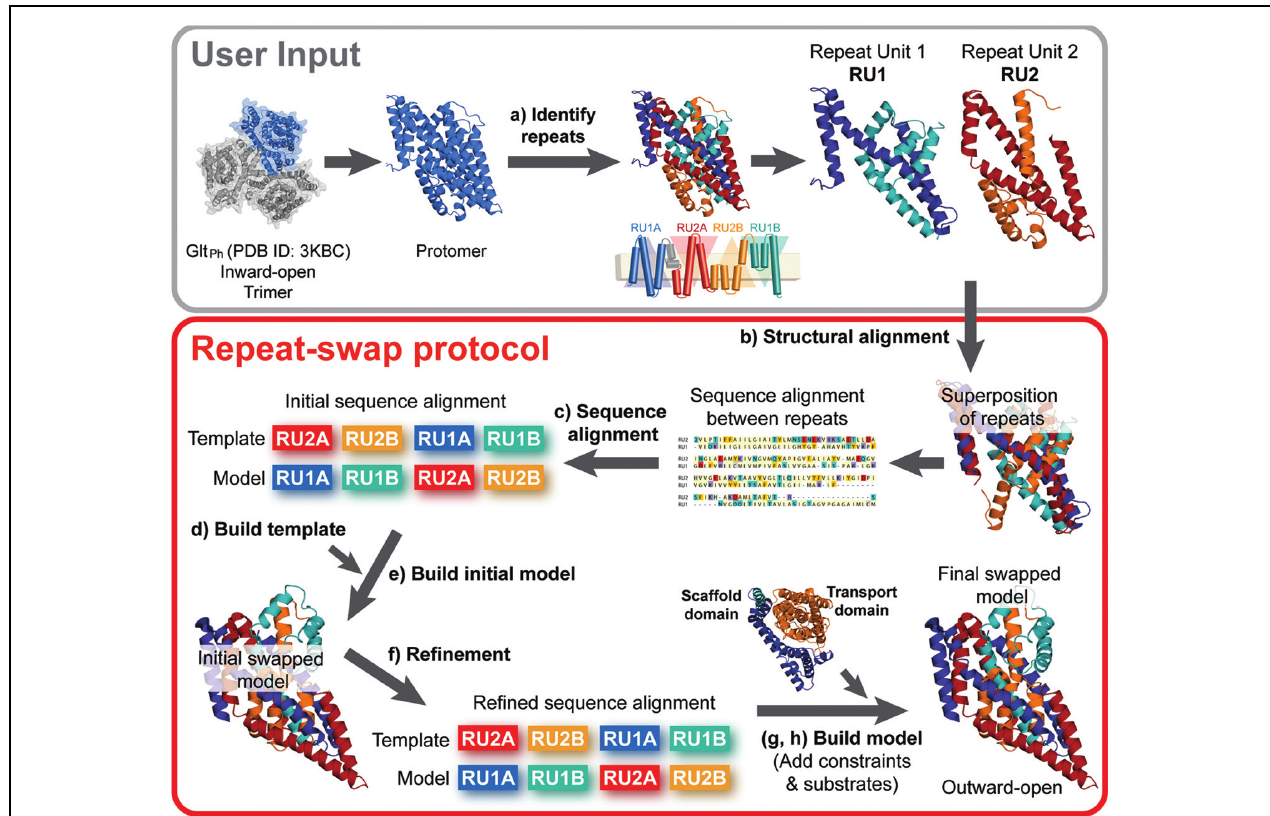
FIGURE 2 | Repeat-swap homology modeling protocol. To build a molecular model of membrane transporters with internal structural pseudo-symmetry, the crystal structure of a protomer of the protein (e.g., Glt Ph ) is required as an input. In step (a) the protomer must be carefully analyzed in order to identify the internal repeats. This information is often provided by the authors that report the structure, however, additional insights may be obtained using SymD and CE-symm. In preparation for the modeling, (b,c) an initial sequence alignment is built from a structural alignment of the repeat units (e.g., RU1 and RU2) using a structure alignment program such as TM-Align. In addition, (d) a template structure is built by changing the order of the repeat units in the PDB file and including the regions of the protein that do not belong to the repeat units. At this point, (e) an initial swapped model of the protein can be built, using Modeler. (f) The input alignment is then carefully refined to optimize the agreement with the secondary structure definition and the evolutionary conservation pattern, obtained with DSSP and ConSurf, respectively. Once a model is built using the optimal alignment, the scaffold and transport domains are identified, where possible. (g) C α -C α distance restraints can then be defined for each of these domains according to the crystal structure values, and the model is rebuilt using those restraints. Finally, (h) substrates are added to the binding site, if known, and the final repeat-swapped model can be compared with the crystal